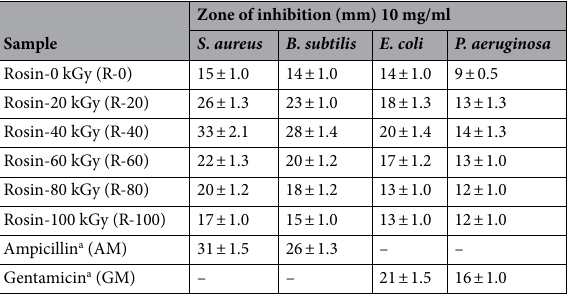
Table 2. Zone of inhibition (mm) 10 mg/ml of R-0, R-20, R-40, R-60, R-80, and R-100 samples. a M w of AM and GM were determined by the manufacturing company as mentioned in the experimental section. Note that each concentration of AM and GM is 10 µg and sued as standard materials.